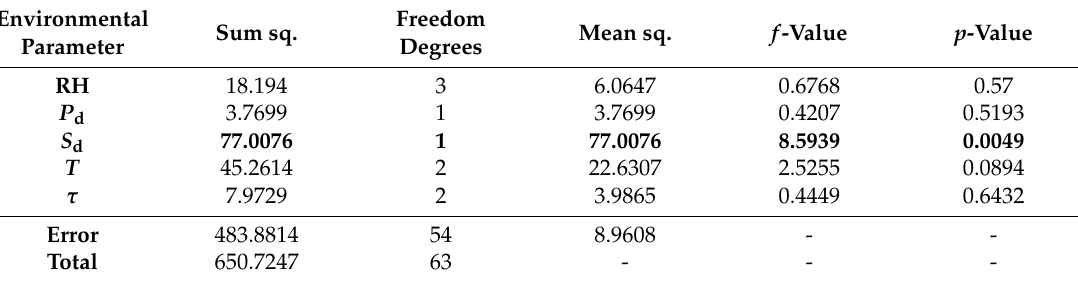
Table 5. Statistical analysis of results for